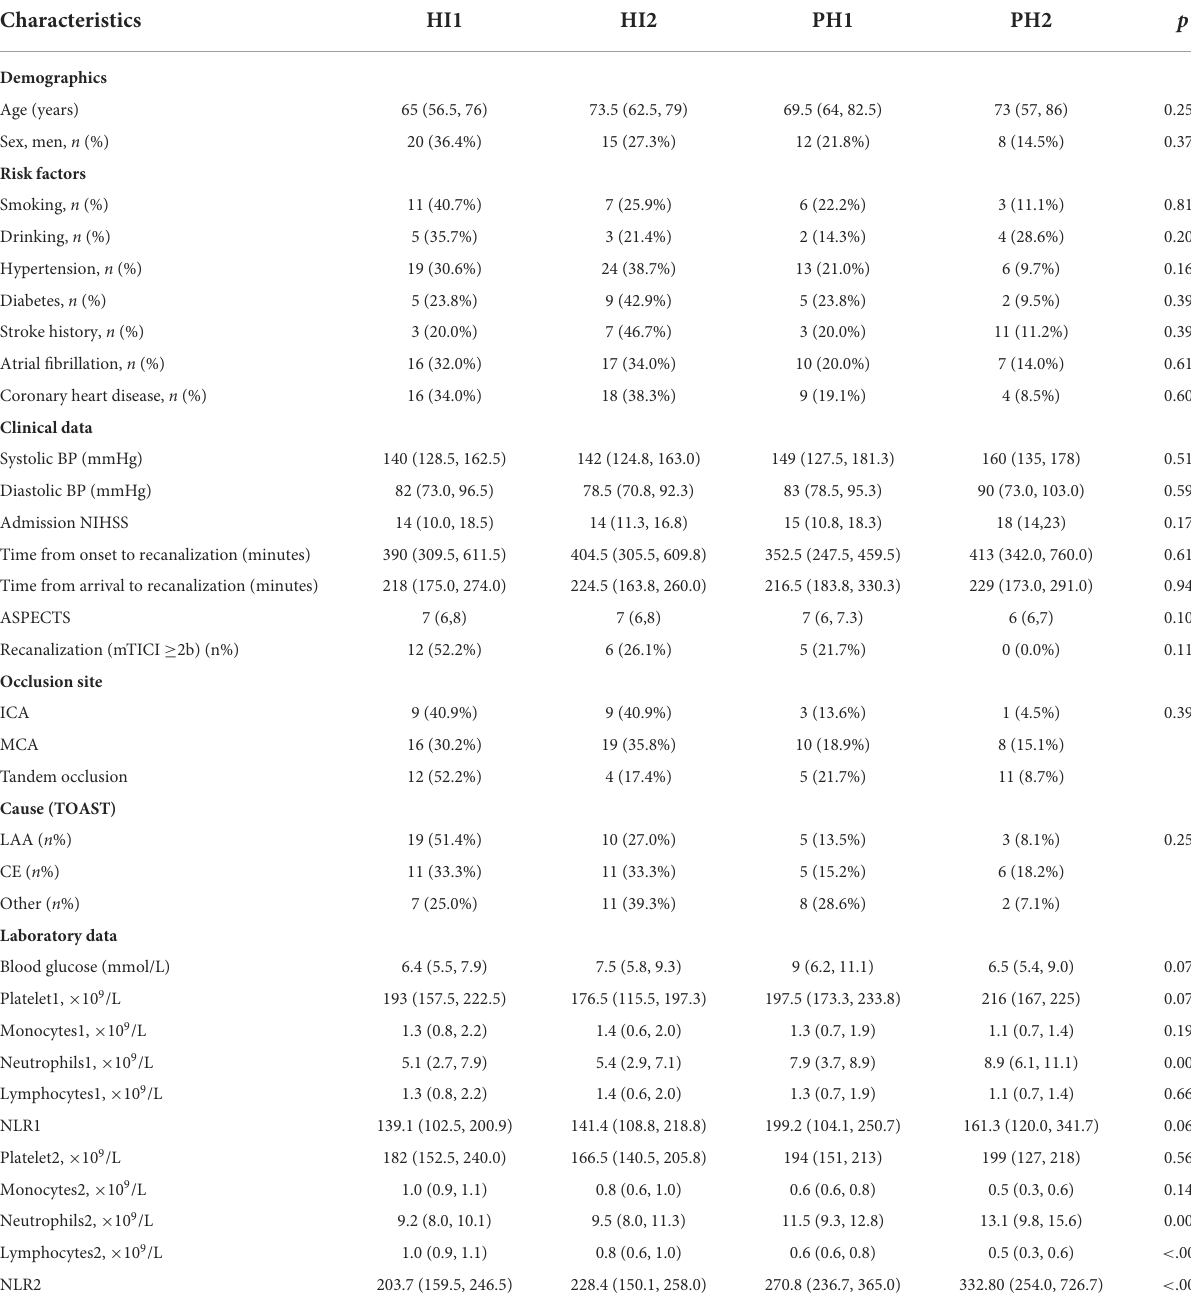
TABLE 4 Baseline demographics and clinical characteristics grouped on the basis of types of HT.